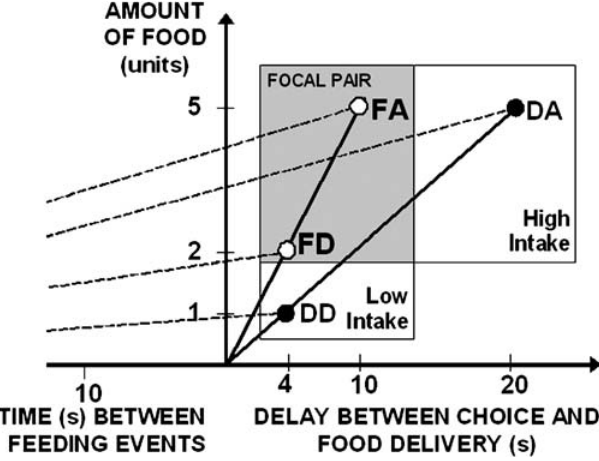
Figure 1. Amount and Delay to Food Corresponding to Each Option The figure shows the parameters of the experiments using the conventional representation used in foraging theory, with energy gains in the ordinate and time in the abscissa. The origin of coordinates is the point of choice, so that time to the right indicates the delay between choice and reward, while time to the left represents all other times in the cycle, in this case the ITI. The options forming the focal choice pair are shown as white circles while those used as decoys are shown by black circles. FA and FD offer the same short- term rate of food intake (slope of the solid lines) of 0.5 units/s, whereas DA and DD offer the same short-term rate of 0.25 units/s. The slopes of the dashed lines (interrupted for space economy) indicate long-term rate of intake, considering the inter-trial interval of 60 s between consecutive feeding opportunities. ‘‘ High intake ’’ (horizontally adjacent rectangles) and ‘‘ low intake ’’ (vertically adjacent rectangles) denote the treatments in which decoy DA and DD (or their simulated energetic consequences), respectively, were present in addition to the focal pair. Since DA offers a higher long- term rate of gain than DD, intake is higher in the treatment where DA is present ( ‘‘ High Intake ’’ ). The reverse rationale applies to treatment ‘‘ Low Intake. ’’